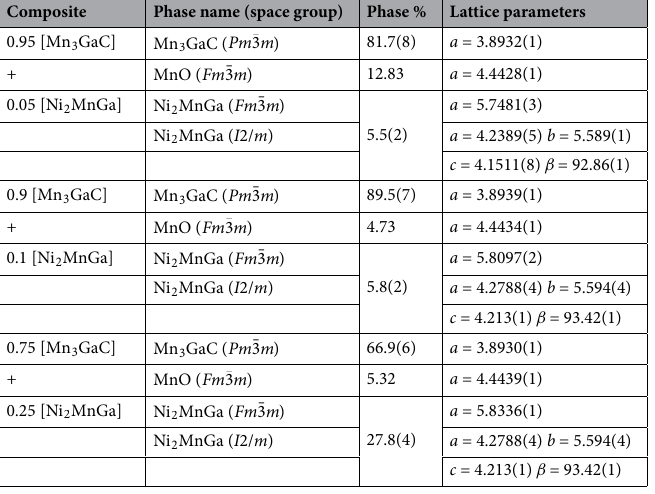
Table 1. The refined crystallographic data for the composites ( 1 − y ) [Mn 3 GaC] + y [Ni 2 MnGa] with y = 0.075, 0.1 and 0.2.